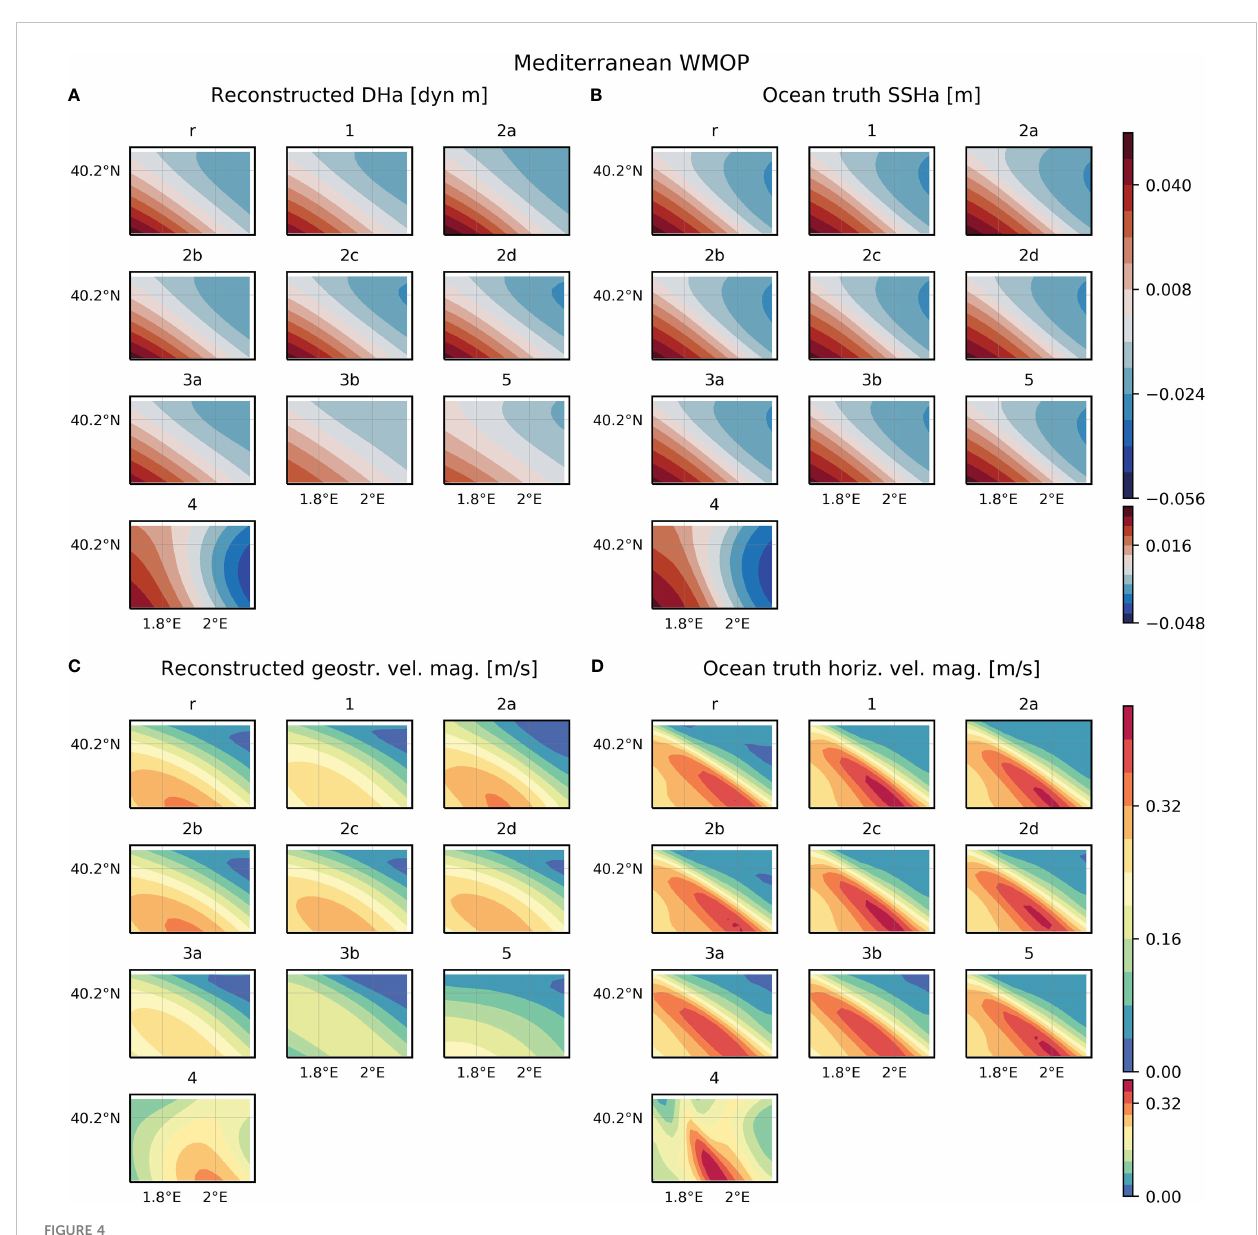
FIGURE 4 (A) Dynamic height anomaly (DHa) at the upper layer reconstructed from each con fi guration simulated from the WMOP model in the Mediterranean study region. (B) Sea surface height anomaly (SSHa) from WMOP on the same date as each reconstruction. To compute anomalies, the spatial average is subtracted to the corresponding fi eld. (C) Geostrophic velocity magnitude at the upper layer reconstructed from each con fi guration simulated from WMOP in the Mediterranean study region. (D) Horizontal velocity magnitude from WMOP on the same date as each reconstruction. Note that to calculate statistics model fi elds are interpolated onto the reconstruction grid and statistics are computed only considering data within the domain of con fi guration